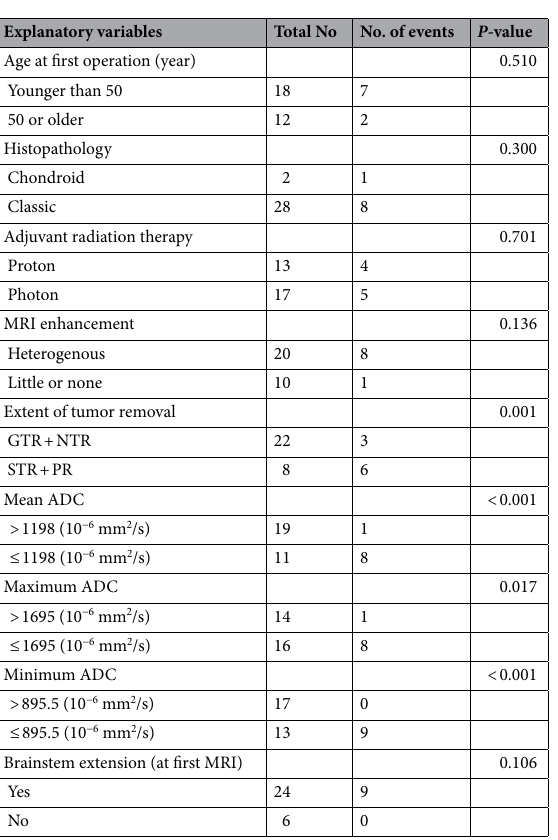
Table 2. Univariable analysis of factors associated with PFS using Kaplan–Meier method. ADC apparent diffusion coefficient, GTR gross total resection, MRI magnetic resonance imaging, NTR near-total resection, PFS progression free survival, PR partial resection, STR subtotal